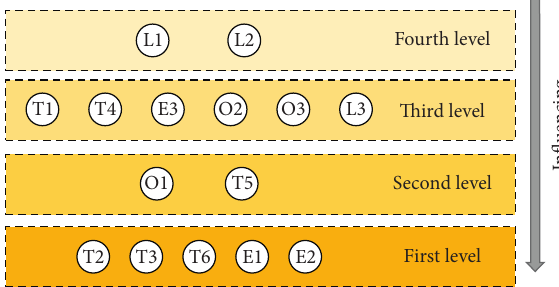
Figure 6: The hierarchical network model among the challenges.